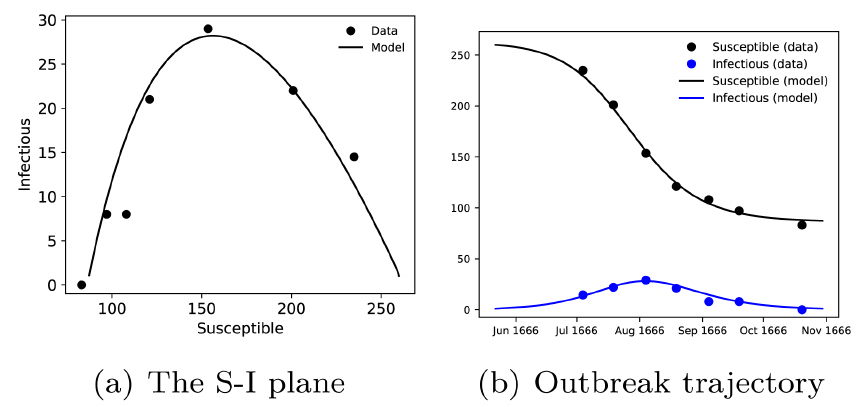
Figure 5. The age-structured SIR model of the Great Plague in Eyam. In ( a ), the simulated numbers of infectious versus susceptible individuals are shown together with the outbreak data. In ( b ), the number of susceptibles and infectious cases are plotted with respect to time for the duration of the outbreak. Model simulations (solid lines) are compared with the outbreak data (dots).